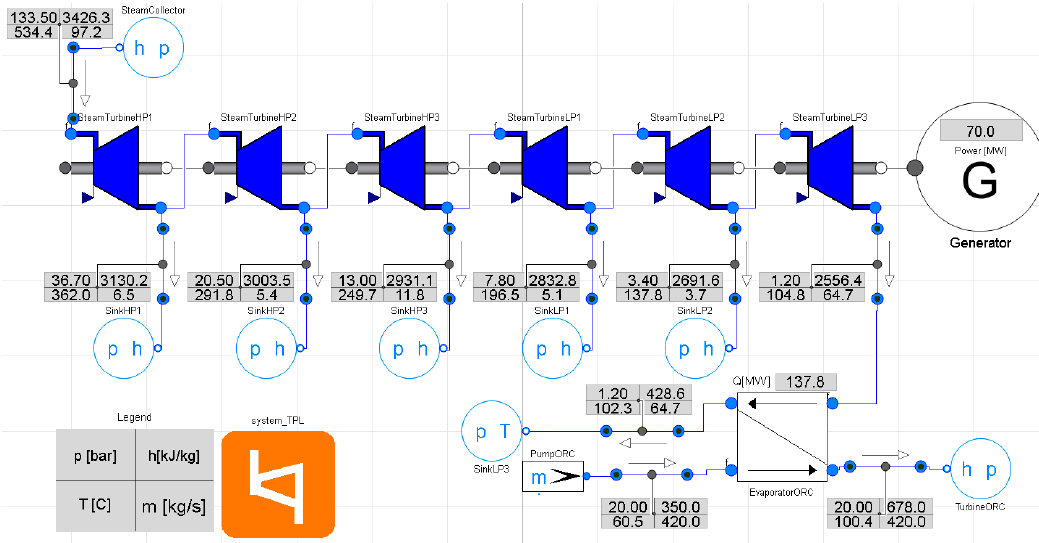
Figure 10. The original BPT with the ORC evaporator at the nominal operation.